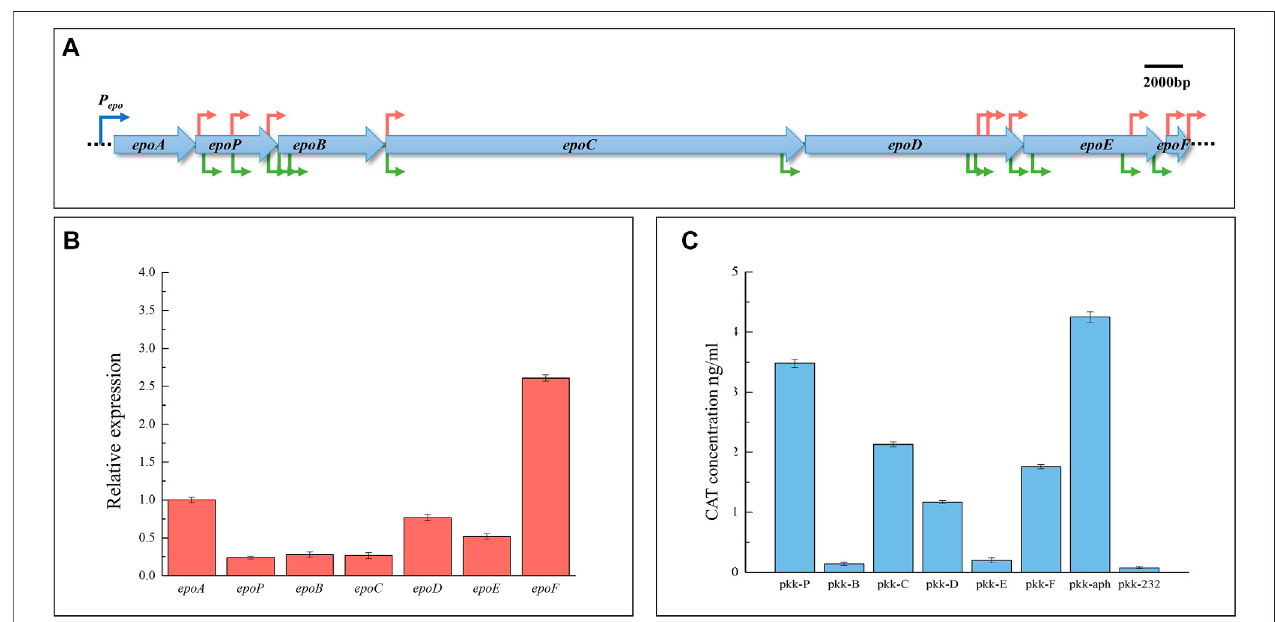
FIGURE 1 | Internal promoters in the epothilone operon and their promotion activities. (A) Prediction of internal promoters in the epothilone operon from S. cellulosum So0157-2. The promoter prediction was performed using two online promoter prediction programs: “ Neural Network Promoter Prediction ” (red arrows) and BPROM(greenarrows). (B) RT-qPCRanalysisofexpressionlevelsofthesevenoperongenesinZE9after48 hofincubation.The epoA expressionwassetas1,andthe expressions of the other six genes are shown as the relative expression of the epoA gene. (C) Activities of the separate internal promoters in E. coli . The activity of thereportergenechloramphenicolacetyltransferase(CAT)wasdetectedbyusingtheCATELISAkit,withthe aphII promoterasapositivecontrolandtheoriginalplasmid pKK-232 as a negative control (no promoter upstream of the reporter gene CAT ).